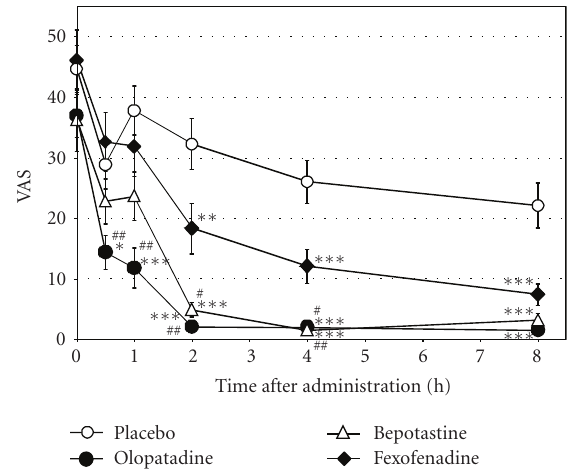
Figure 2: Inhibitory e ff ects of anti-histamines on VAS values of histamine-induced itching sensation after histamine iontophoresis ( n = 10). Results are presented as mean ± SE. ∗ P < .05, ∗∗ P < .01, and ∗∗∗ P < .001 (olopatadine versus placebo); # P < .05, ## P < .01 (olopatadine versus fexofenadine).